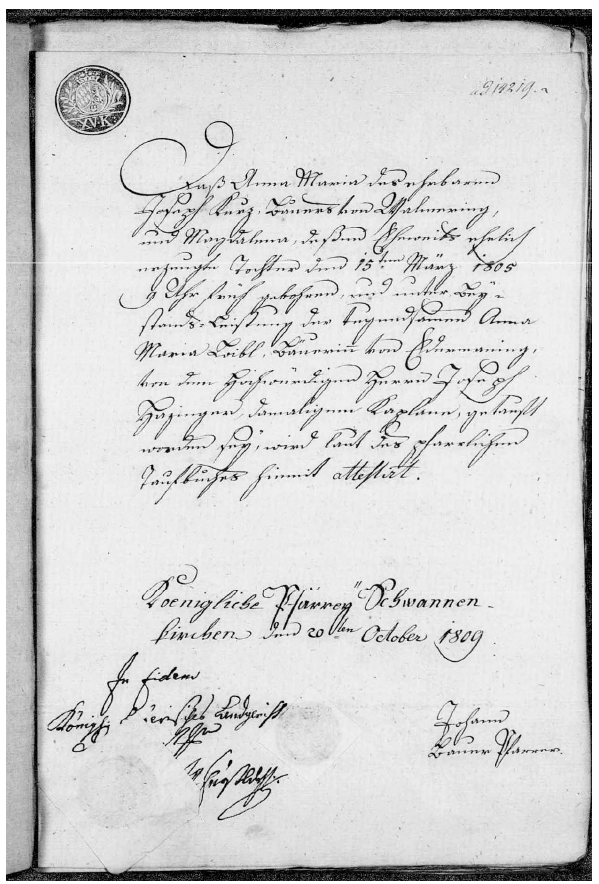
Figure 7. A record stating that Anna Maria Kurz, born 15 March 1805, was baptized.